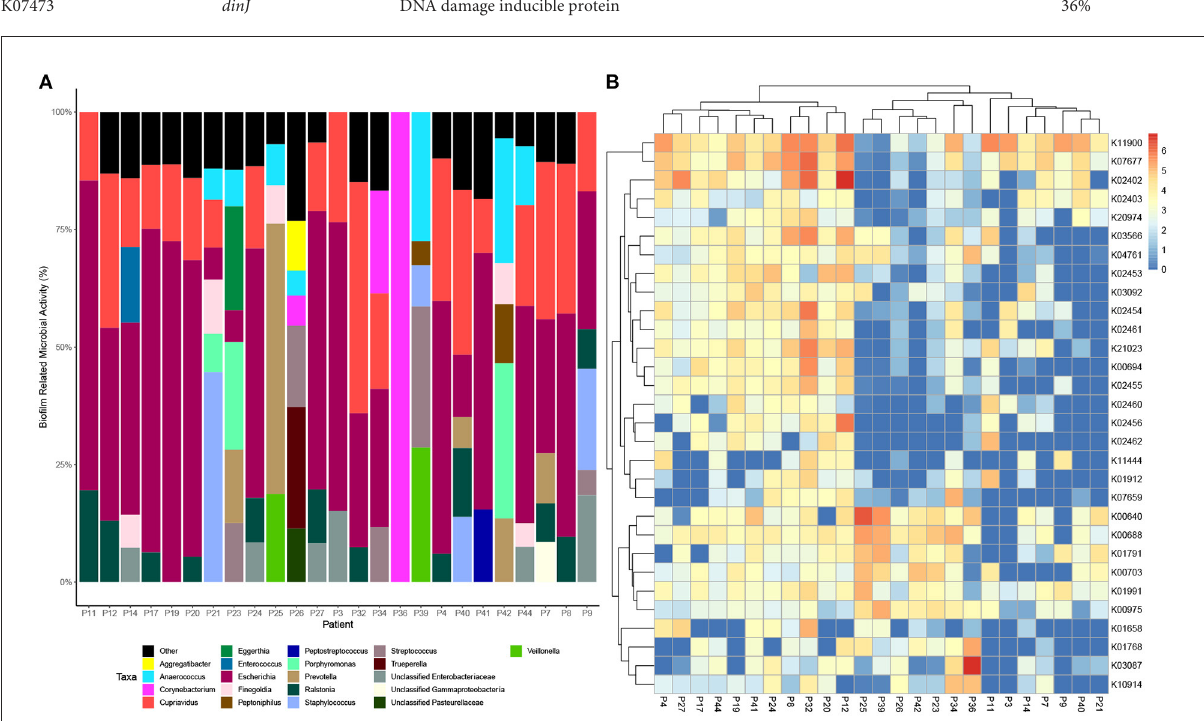
FIGURE3 Taxonomic and functional distribution of metatranscriptomic data associated with biofilm. (A) Bar chart highlighting taxonomy at the genus level that represent > 5% of pathogenic activity. (B) Heatmap highlighting the top 30 expressed transcripts across all samples normalized to LogTPM.